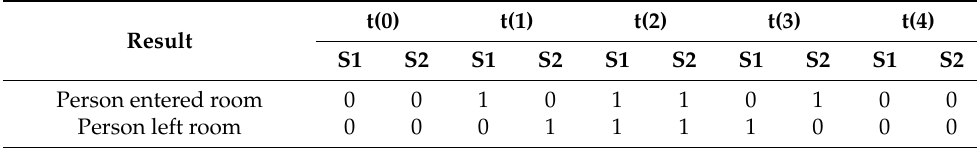
Table 1. Sequences for successful door crossing